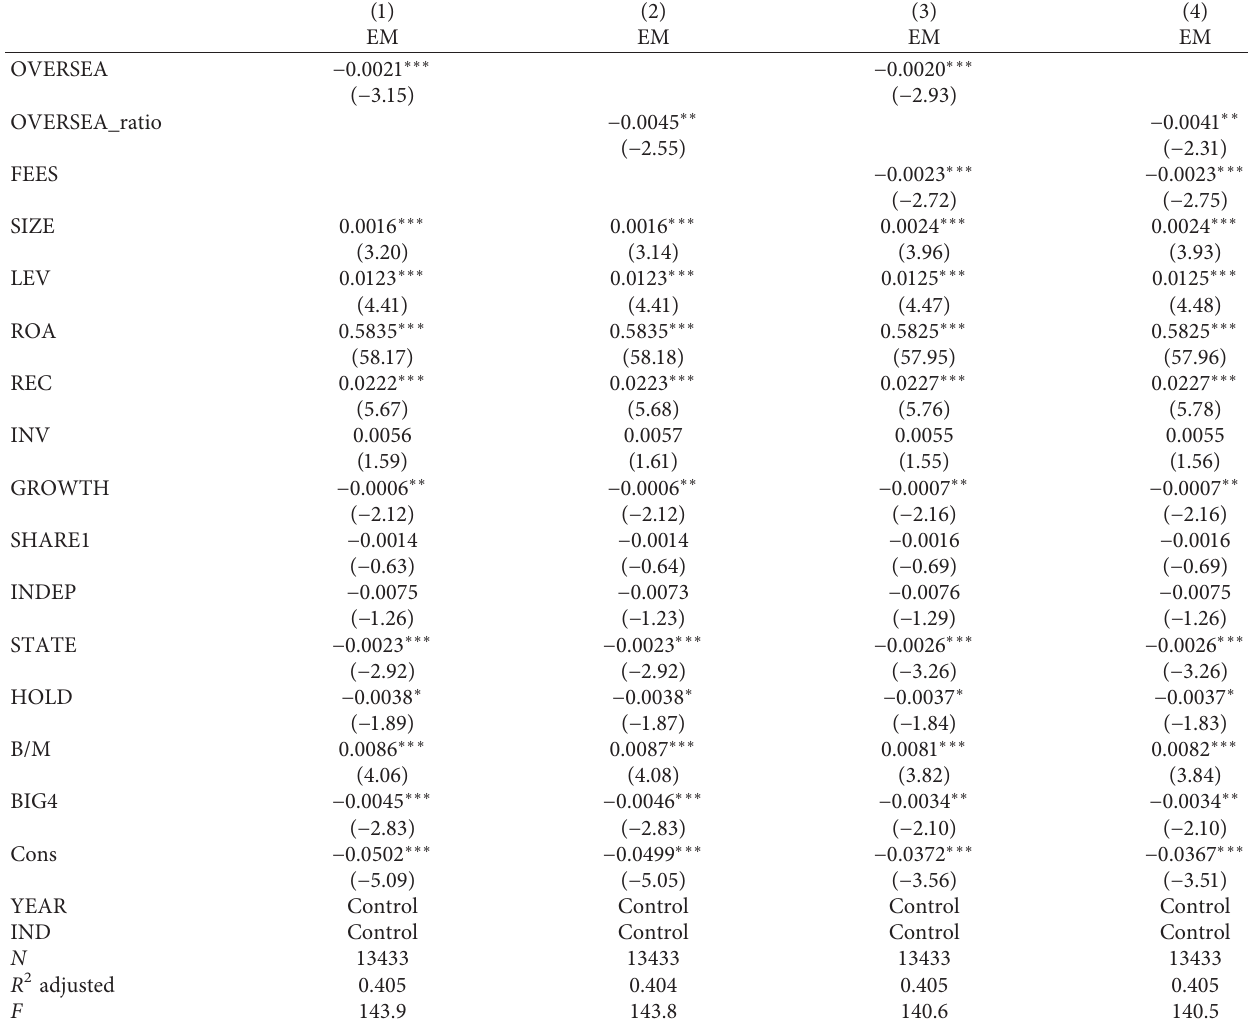
Table 10: Audit committee overseas experience and earnings management.